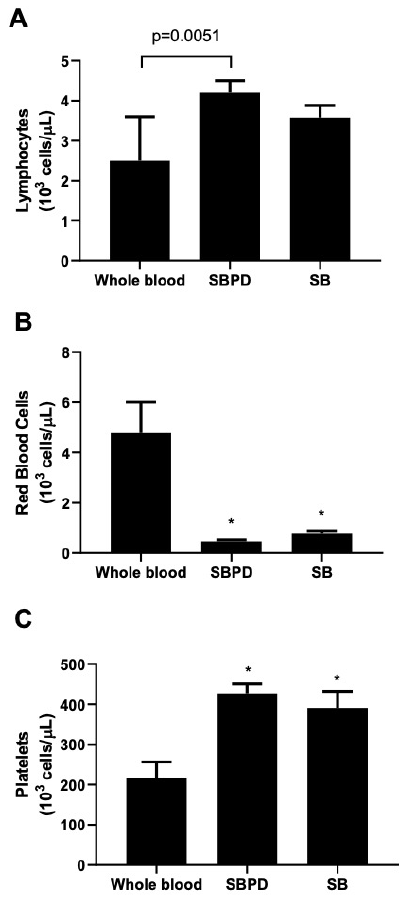
Figure 4. Cell content of the hand-mixed (SB) and SBPD ® sticky bone preparations, as compared to whole-blood samples, represented by the mean ± SD of lymphocytes ( A ), red blood cells ( B ), and platelets ( C ). An asterisk (*) indicates a significant difference from the whole-blood group ( p < 0.05). Results indicate the mean ± SD of three biological replicates with three technical replicates.